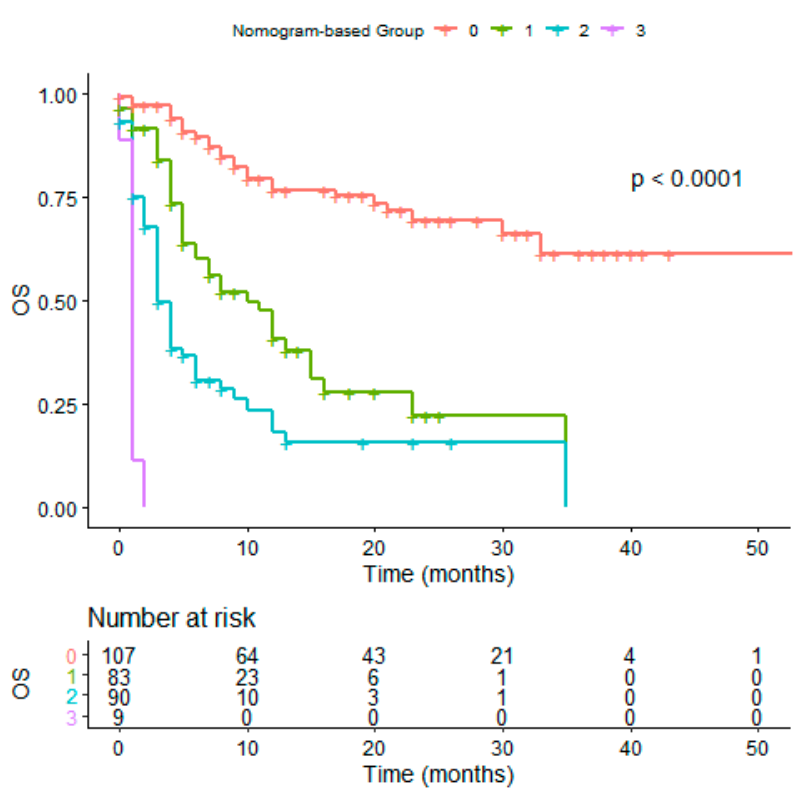
Figure 2. ( a ) 12-month OS nomogram; ( b ) 24-month OS nomogram; ( c ) 12-month PFS nomogram.